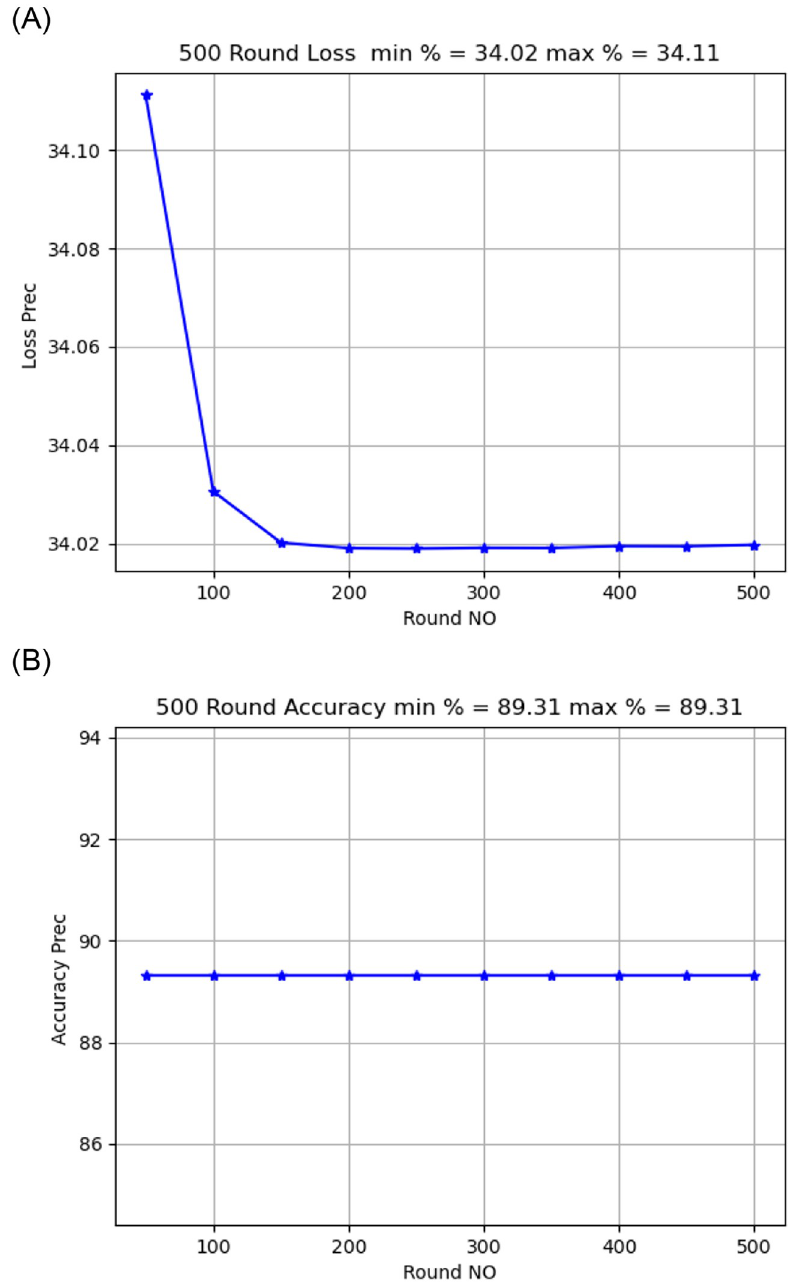
Fig 12. Model accuracy and loss comparison for 500